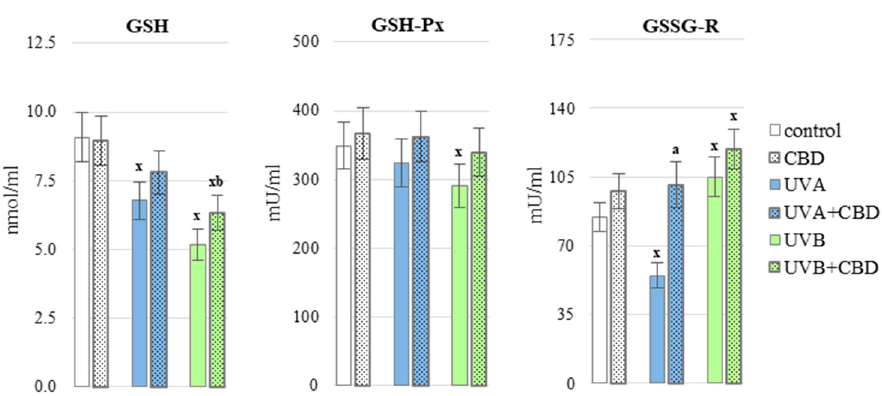
Figure 4. The level of glutathione (GSH) and the activity of the GSH-dependent enzymes (glutathione peroxidase (GSH-Px) and glutathione reductase (GSSG-R) in the blood plasma of nude rats, in the following groups: control; treated with CBD (every 12 h) for 4 weeks; irradiated with UVA (every